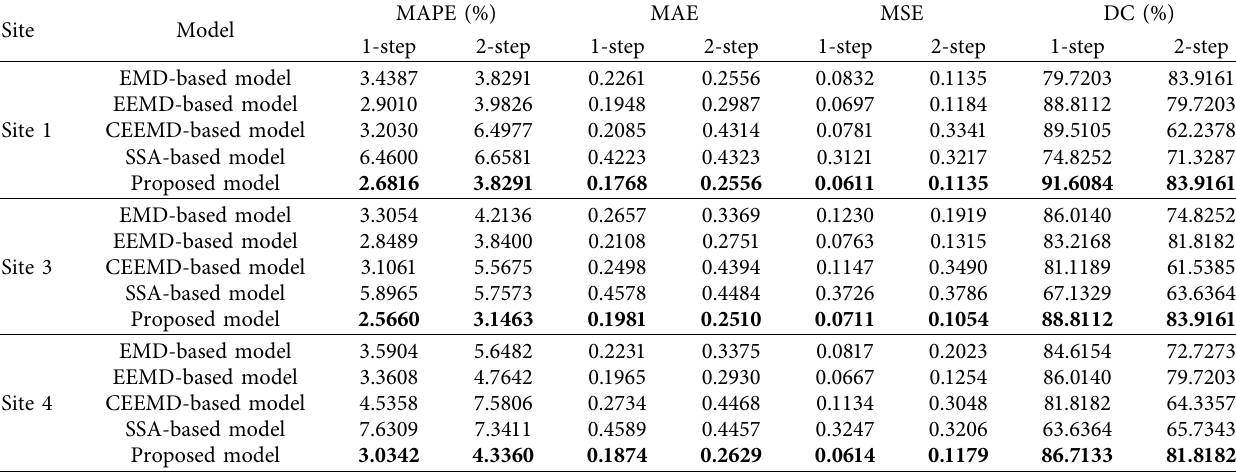
Table 6: Performances of models with different data preprocessing techniques.